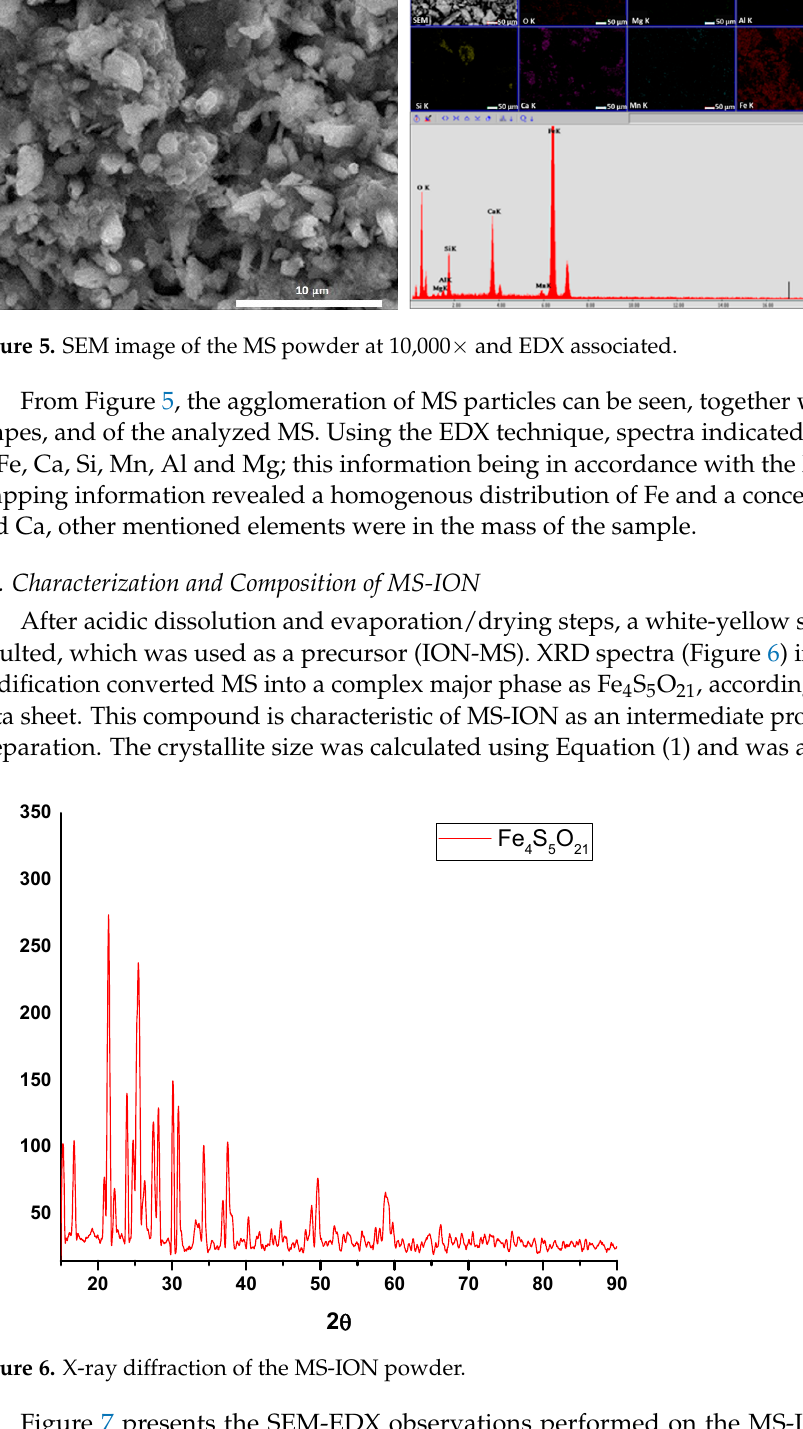
Figure 4. X-ray diffraction of the MS powder and percentage of identified phases (inset).